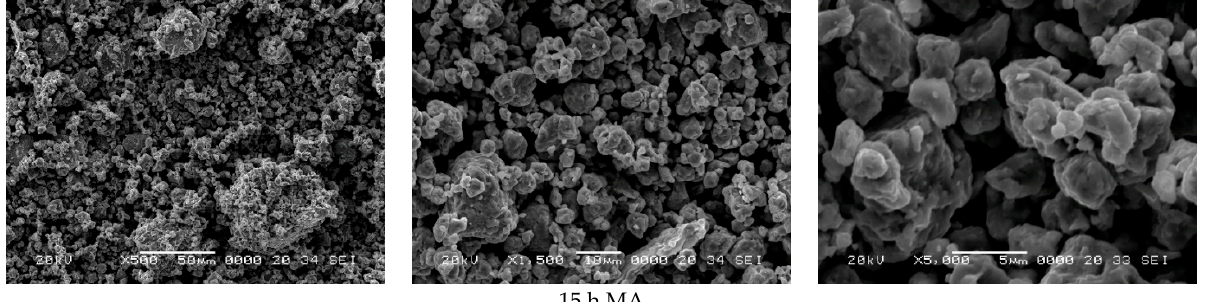
Figure 2. Scanning electron microscopy images in secondary electron mode of the sample milled for 2, 6, 10, and 15 h.